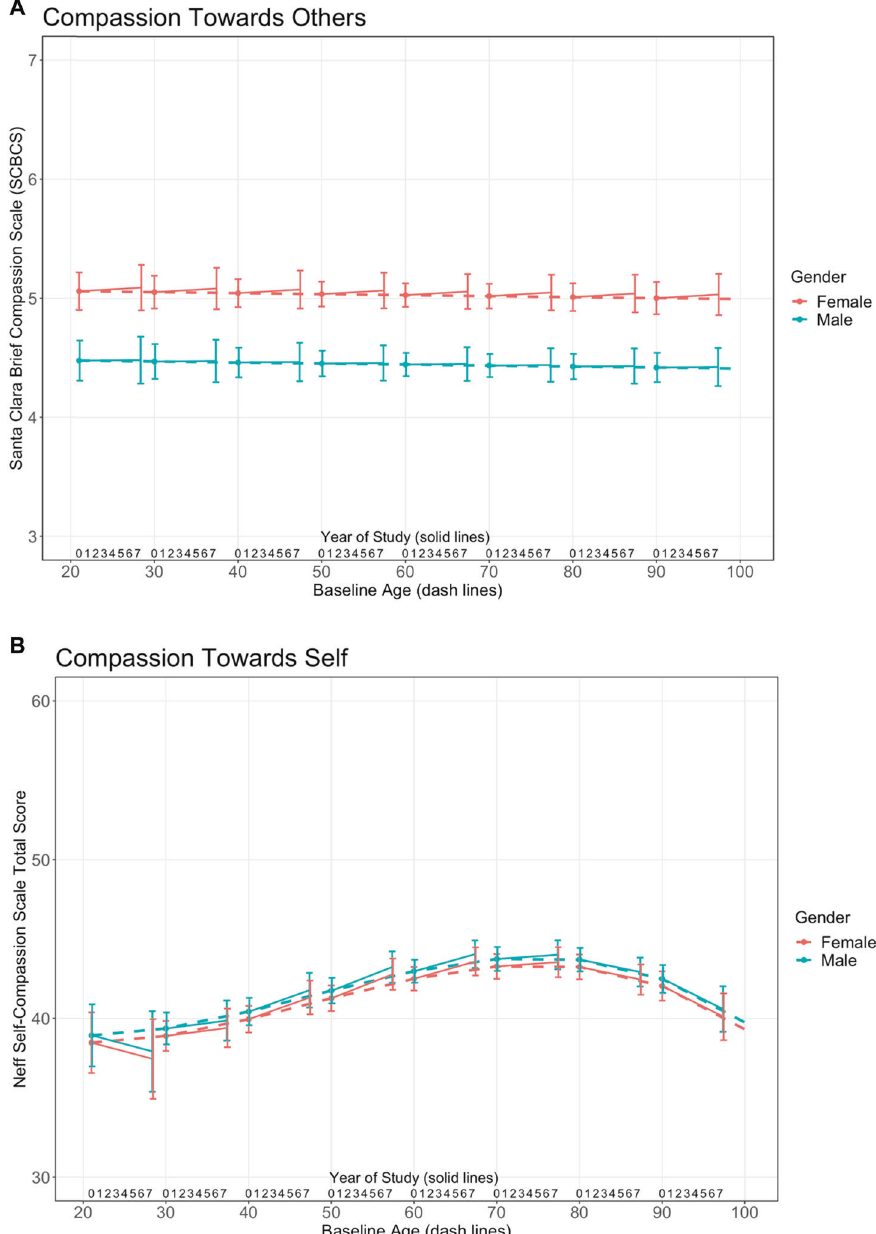
Fig. 1 Trajectories of compassion toward others (CTO) and compassion toward self (CTS) by age and gender. A Trajectories of compassion toward others (CTO) by Age and Gender (Mean follow-up 4.8 years, up to 7 years). Solid lines depict the changes in CTO levels up to 7 years of follow-up by decade of age. Dotted lines show the best- fi t model of CTO with baseline age. B Trajectories of compassion toward self (CTS) by age and gender (mean follow-up 4.8 years, up to 7 years). Solid lines depict the changes in CTS levels up to 7 years of follow-up by decade of age. Dotted lines show the best- fi t model of CTS with baseline